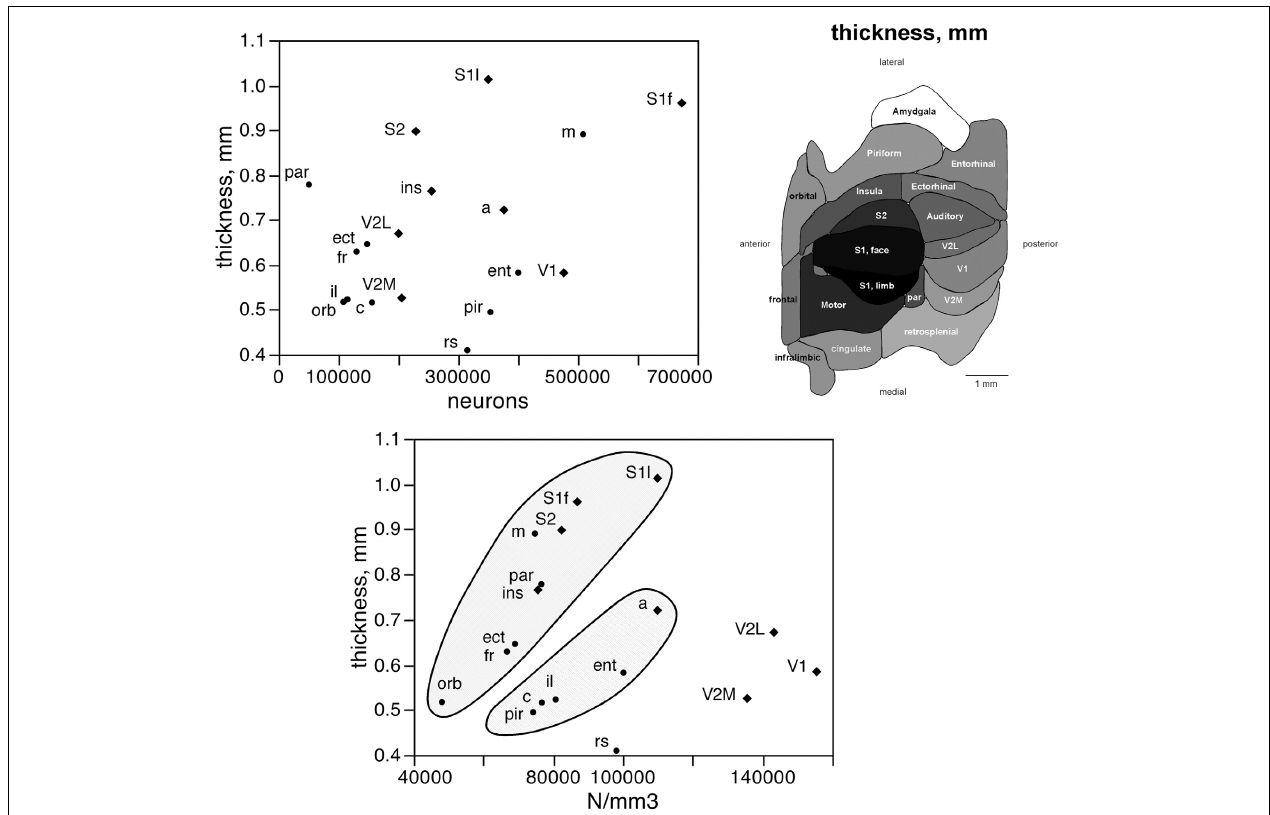
FIGURE 5 | Cortical thickness is not a simple function of the number of neurons across functional areas. Top left, average thickness of each functional area plotted as a function of the average number of neurons found in that functional area. There is no significant correlation between the two variables ( p = 0 . 2798). Top right, variation in average thickness of the gray matter of each functional area. Gray levels represent average